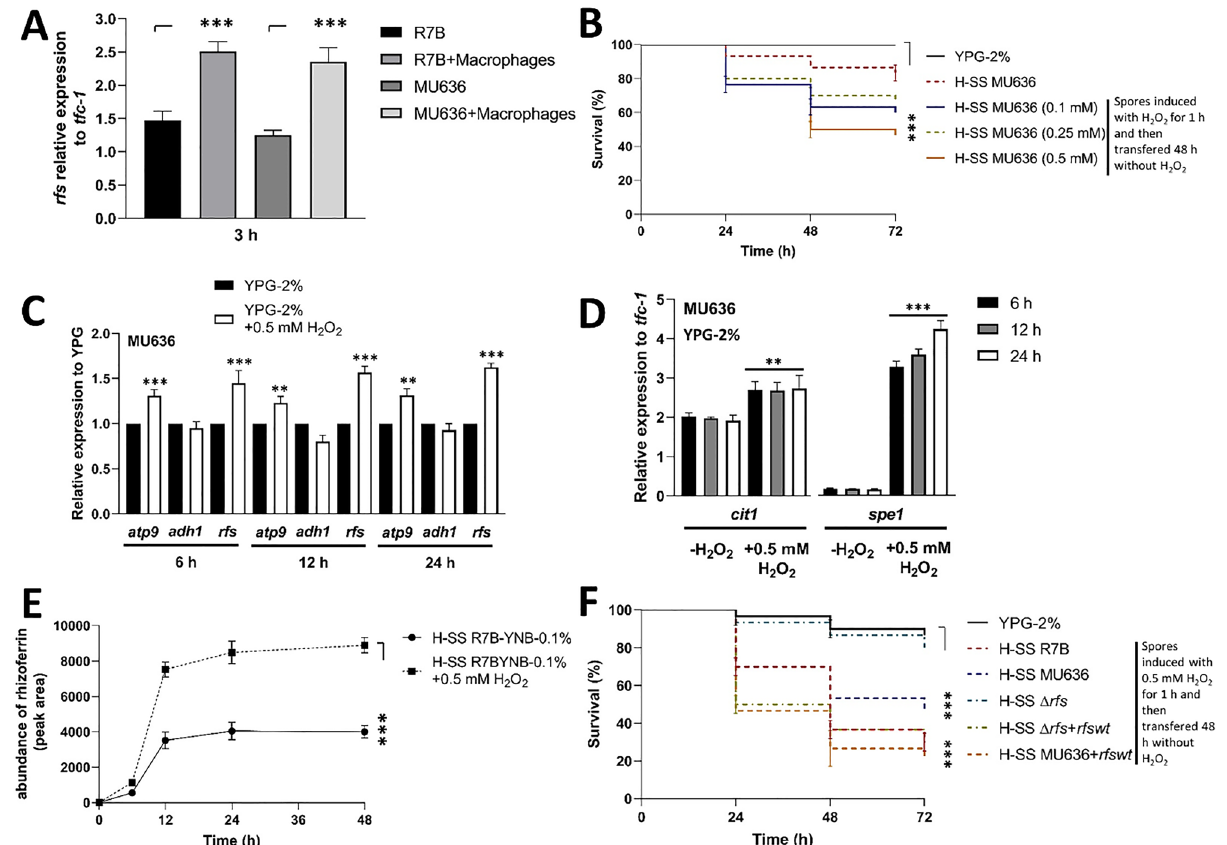
Figure 6. Virulence, rfs transcript levels, and rhizoferrin accumulation are influenced by oxidative stress and macrophage interaction. ( A ) mRNA levels of rfs in Mucor lusitanicus were determined after interaction with macrophages (or not) for 6 h. ( B ) Spores of the MU636 strain were incubated with different concentrations of H 2 O 2 for 1 h in YPG with 2% glucose (YPG-2%), following which the germinating spores were grown aerobically for 48 h in YPG-2% The toxicity of the cell-free supernatant of the culture (SS) obtained after 48 h of aerobic growth (H-SS) was assessed against the nematode. ( C ) mRNA levels of atp9 , adh1, and rfs; ( D ) cit1 and spe1 expression was quantified in the mycelium of the MU636 strain grown for 8 h in YPG-2% in the absence or presence of 0.5 mM H 2 O 2 . ( E ) Relative abundance of rhizoferrin in SS obtained from the R7B strain of M. lusitanicus grown in YNB with 0.1% glucose (YNB-0.1%) in the absence or presence of 0.5 mM H 2 O 2 . ( F ) The virulence of the SSs obtained after 48 h of growth of different strains in YPG-2% in the absence or presence of 0.5 mM H 2 O 2 was assessed in the nematode. The SSs were used to treat Caenorhabditis elegans . A total of 15–20 nematodes were used per experiment and incubated at 18 °C for 72 h. The results presented are the average of values obtained from four independent experiments. Data were statistically analyzed using the Mantel-Cox test for virulence assays. *** P < 0.01. Significance testing was performed using ANOVA with Fisher’s exact test, * P < 0.05; ** P < 0.01; *** P < 0.001. When results were not considered significant, we did not provide an additional indication ( P >